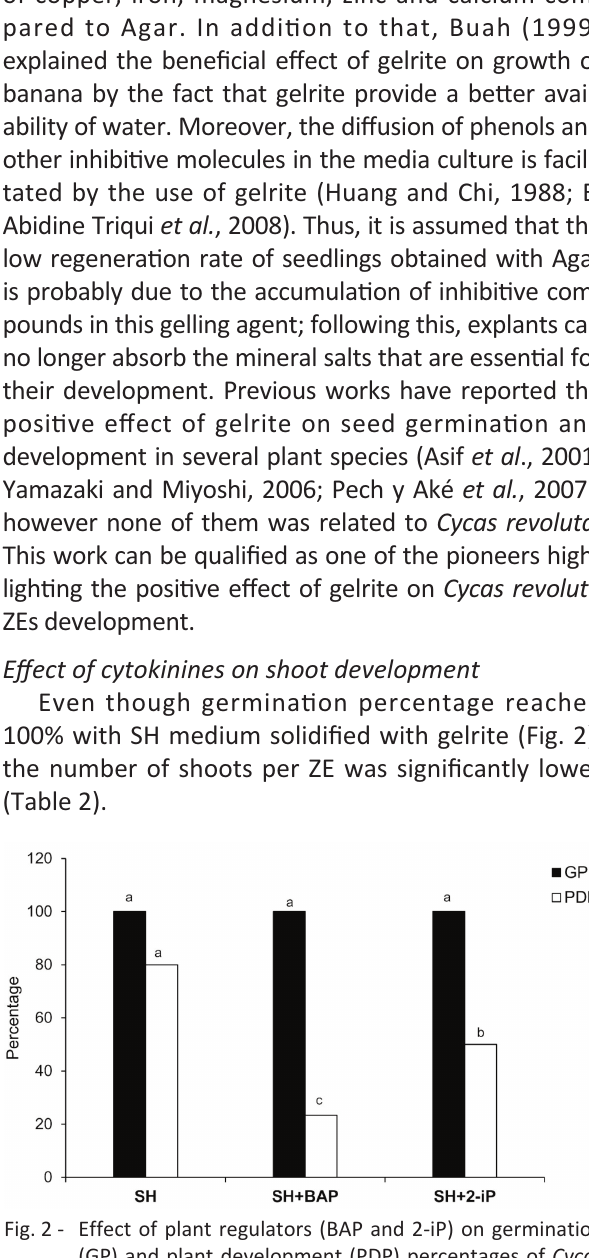
Fig. 1 ­ Effect of gelling agent (agar or gelrite) on germination (PG) and plant development (PDP) percentages. Bars with different letters indicate the statistical significance (p<0.05) according to LSD test. Table 2 ­ Effect of phytohormones on the number of shoot/ explant, number of leaves/ shoot and shoot length of Cycas revoluta ZEs.